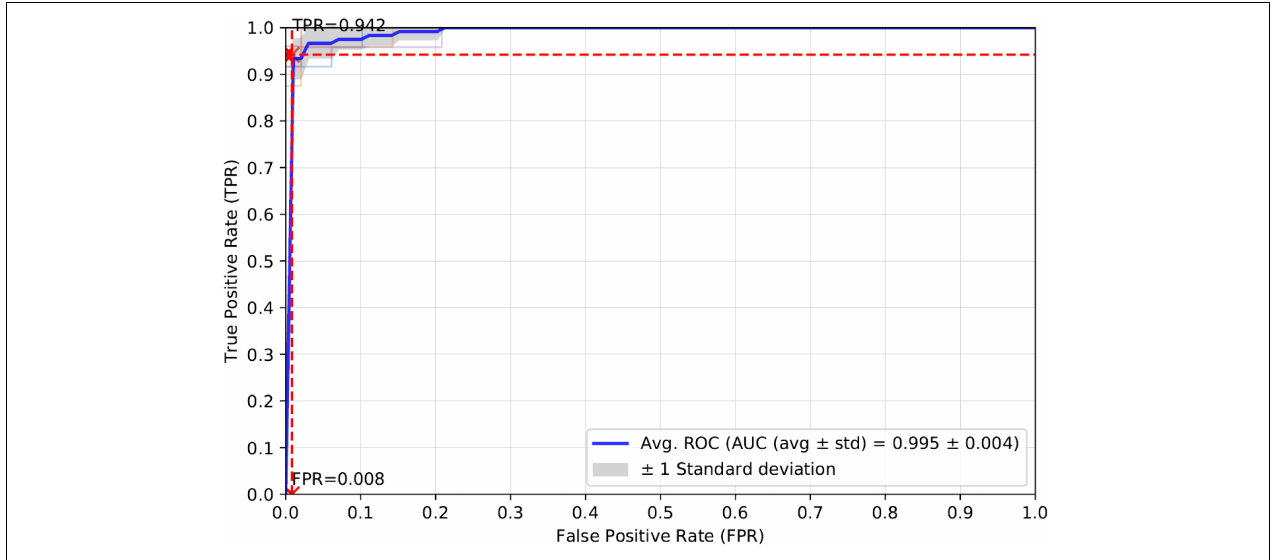
FIGURE 3 | ROC curves for five-fold cross-validation of our proposed